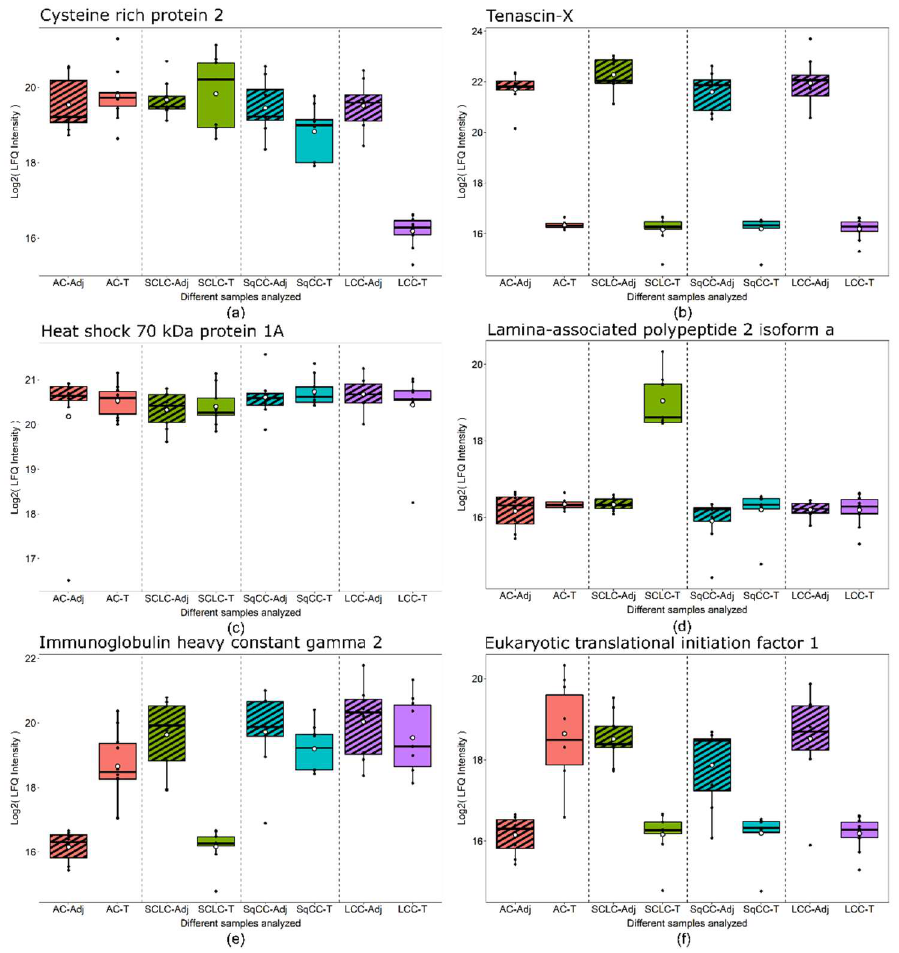
Figure 4 . Box plots of protein examples for distinct expression patterns observed. ( a ) Cysteine-rich protein 2 showed under-expression in only LCC tumor tissue. ( b ) Tenascin-X was under-expressed in all tumor tissue types compared to adjacent tissue. ( c ) Heat shock 70 kDa protein 1A did not show differential expression between any tissue-pairs. ( d ) Lamina-associated polypeptide 2, isoform alpha was overexpressed in only SCLC tumor tissue. ( e ) Immunoglobulin heavy constant gamma 2 was overexpressed in AC tumor, while under-expressed in SCLC tumor compared to adjacent tissue. ( f ) Eukaryotic translational initiation factor 1 was overexpressed in AC tumor while under-expressed in all other tumor types compared to adjacent tissue. Boxes that represent adjacent tissue are striped, while tumor tissue are filled without pattern.